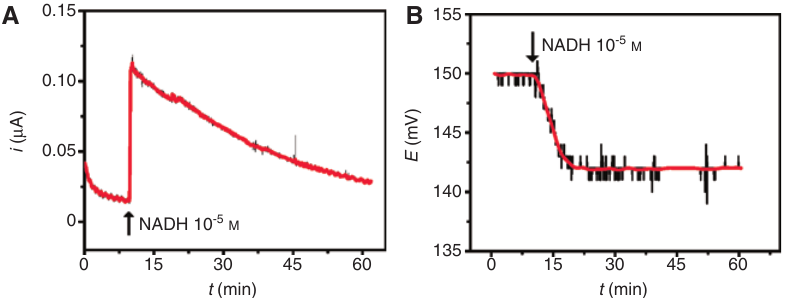
Figure 9: Amperometric response of a bare glassy carbon electrode (A) and potentiometric response of the copper-ion selective electrode (B) to a solution of NADH over 60 min. Reproduced with permission from Chumbimuni-Torres and Wang